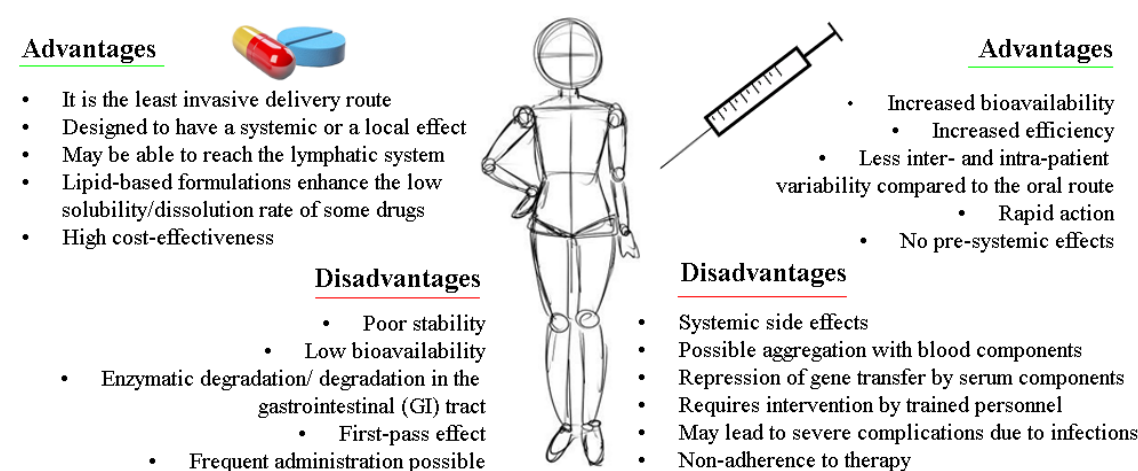
Figure 3: Advantage and disadvantage in oral and intravenous route for siRNA delivery, (Antimisiaris et al., 2021; Fumoto et al., 2021; van den Berg et al., 2021; Lorscheider et al., 2021; Hanna and Mayden,